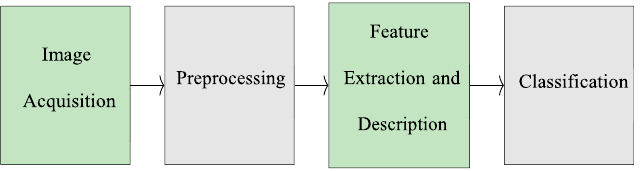
Fig. 1. Generic steps of an image-based plant